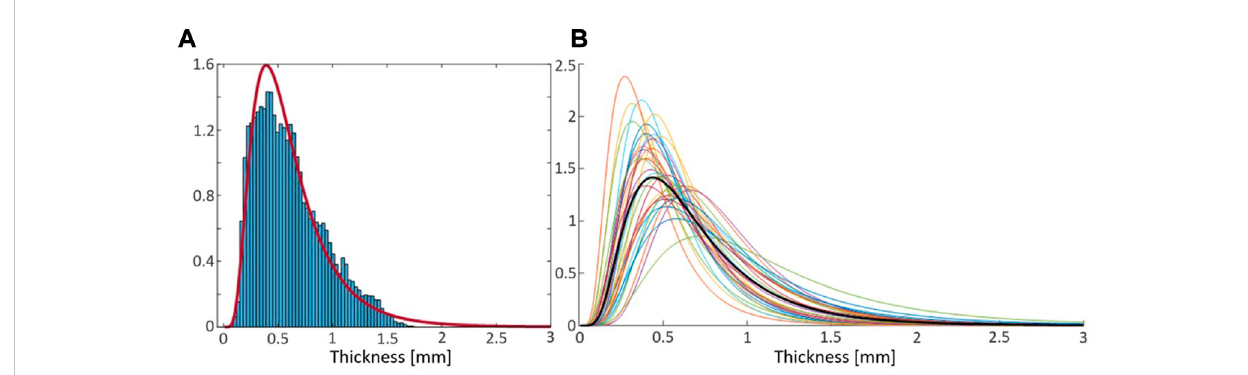
FIGURE 3 (A) :Densityhistogramofallribcorticalbonethicknessmeasurementsfromarepresentativeindividual (bluebars)andprobabilitydensity functionof the corresponding fi tted log-normal distribution (red curve). (B) : Probability density functions of fi tted log-normal distributions from all 33 individuals in Holcombe et al. (2019), and the distribution from mean of fi tted parameters (thick black curve).